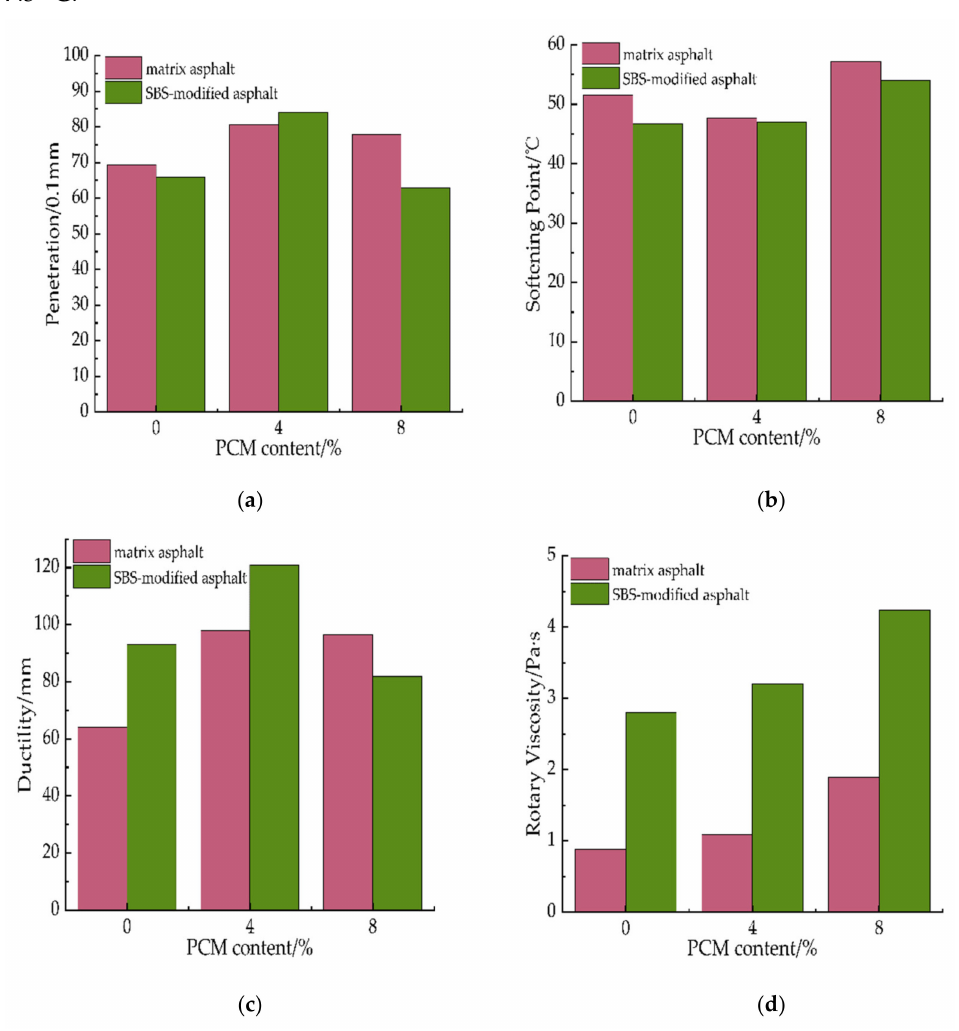
Figure 1. Physical property test results of asphalt samples with and without PCM. ( a ) penetration test results; ( b ) softening point test results; ( c ) ductility test results; ( d ) rotary viscosity test